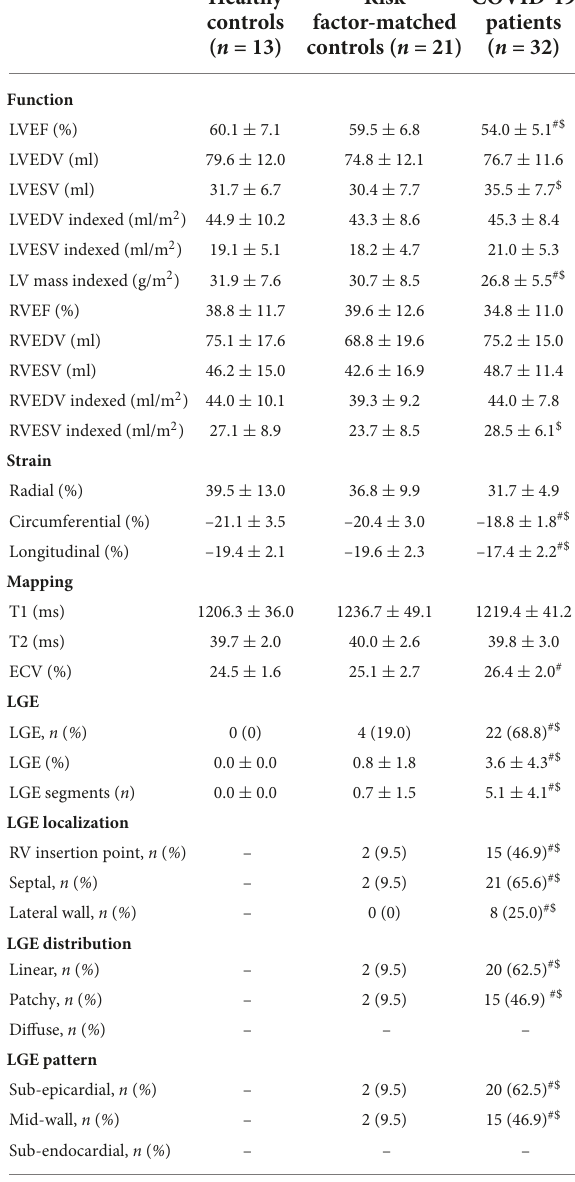
Continuous data are presented as mean ± SD and categorical variables are summarized aspercentageinparentheses. LVEF, left ventricular ejection fraction; LVEDV, left ventricular end-diastolic volume; LVESV, left ventricular end-systolic volume; LV, left ventricular; RVEF, right ventricular ejection fraction; RVEDV, right ventricular end-diastolic volume; RVESV, right ventricular end-systolic volume; ECV, extracellular volume; LGE, late gadolinium enhancement;RV,rightventricular. * p < 0.05,healthycontrolsvs.riskfactor-matchedcontrols. # p < 0.05,healthycontrolsvs.COVID-19patients. $ p < 0.05,riskfactor-matchedcontrolsvs.COVID-19patients.